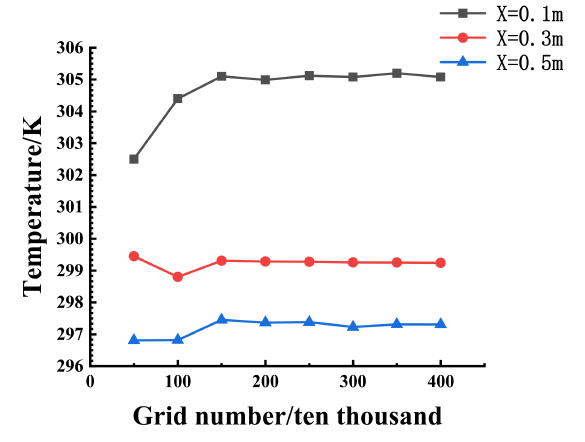
Figure 2. Grid independence test.